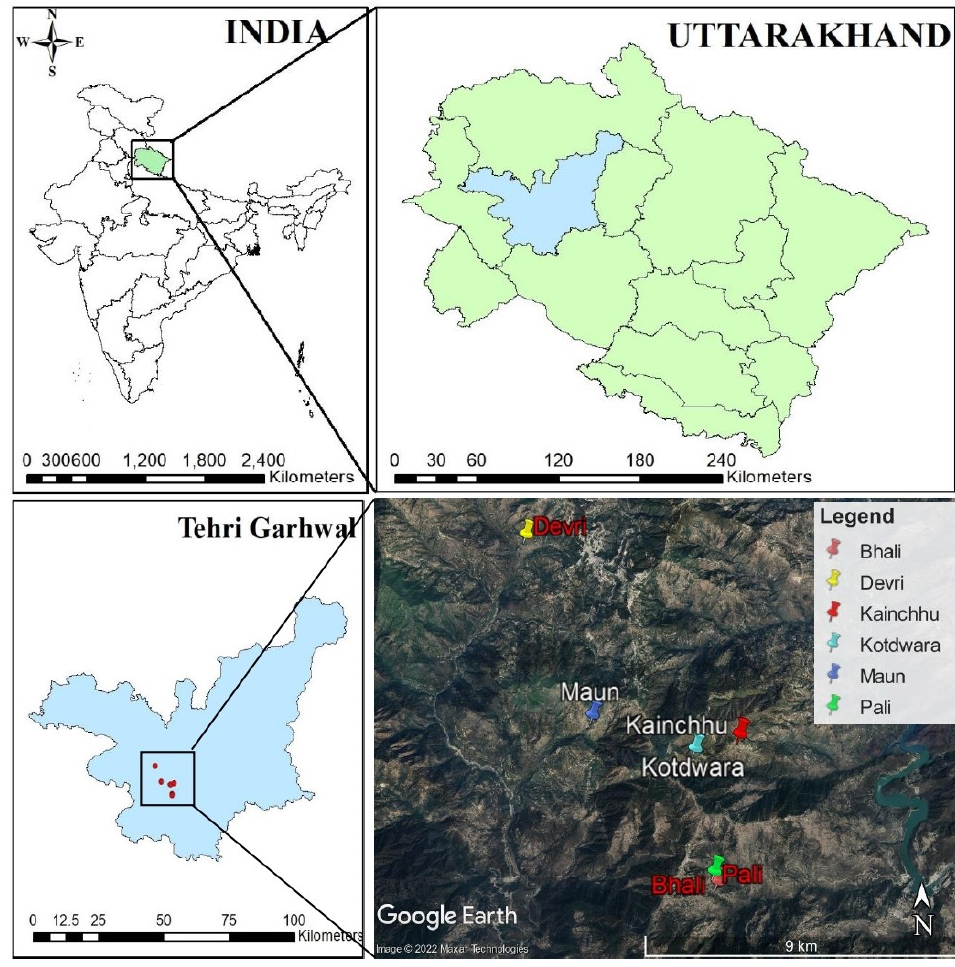
Figure 2. The location map of the study area.